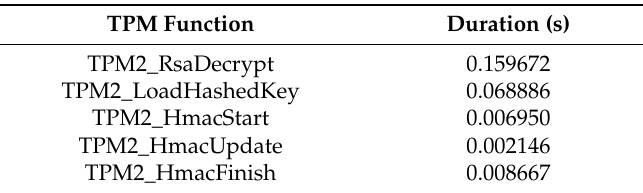
Table 3. Measurements of the executed TPM functions related to the authentication messages based on keyed-hash functions (HMAC) based proposed